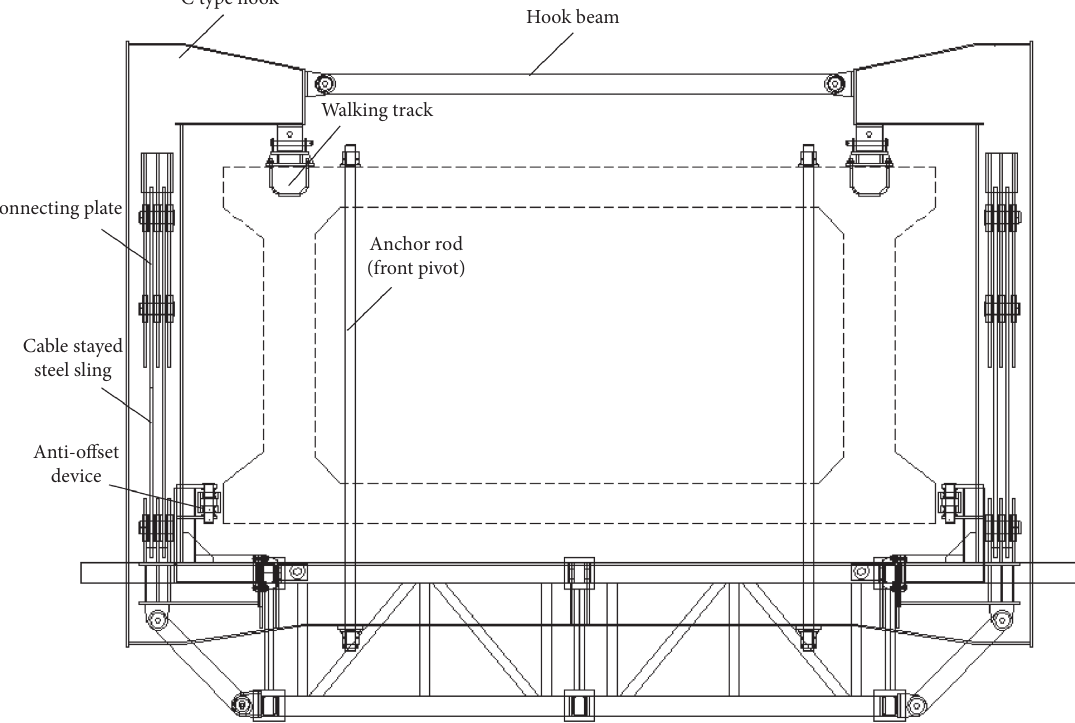
Figure 16: Side view of the new triangular truss hanging